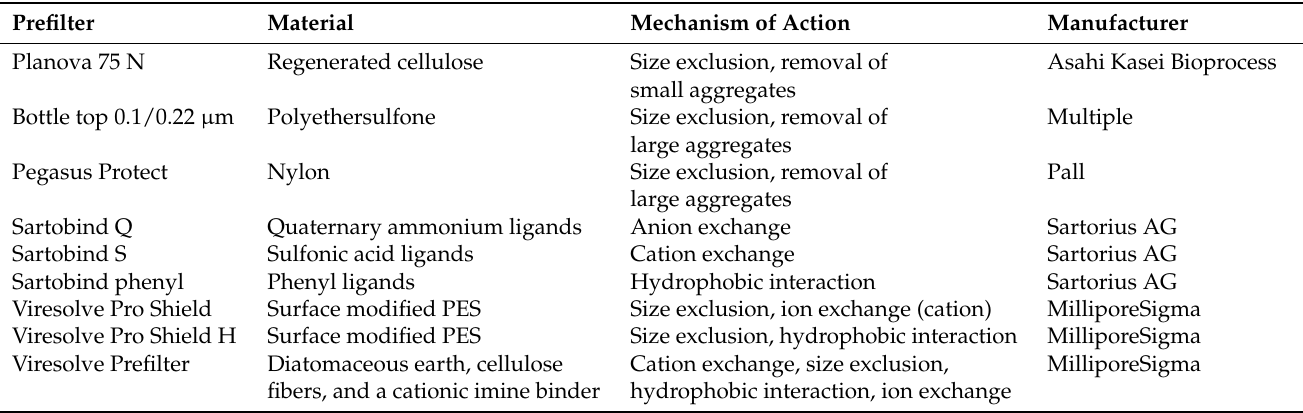
Table 4. Commercially available prefilters, modes of action, and manufacturers